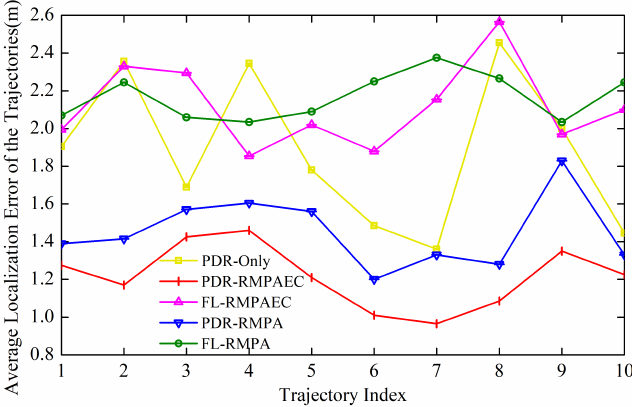
Figure 8. ALE comparison between different methods of trajectories on Route III in Area A.